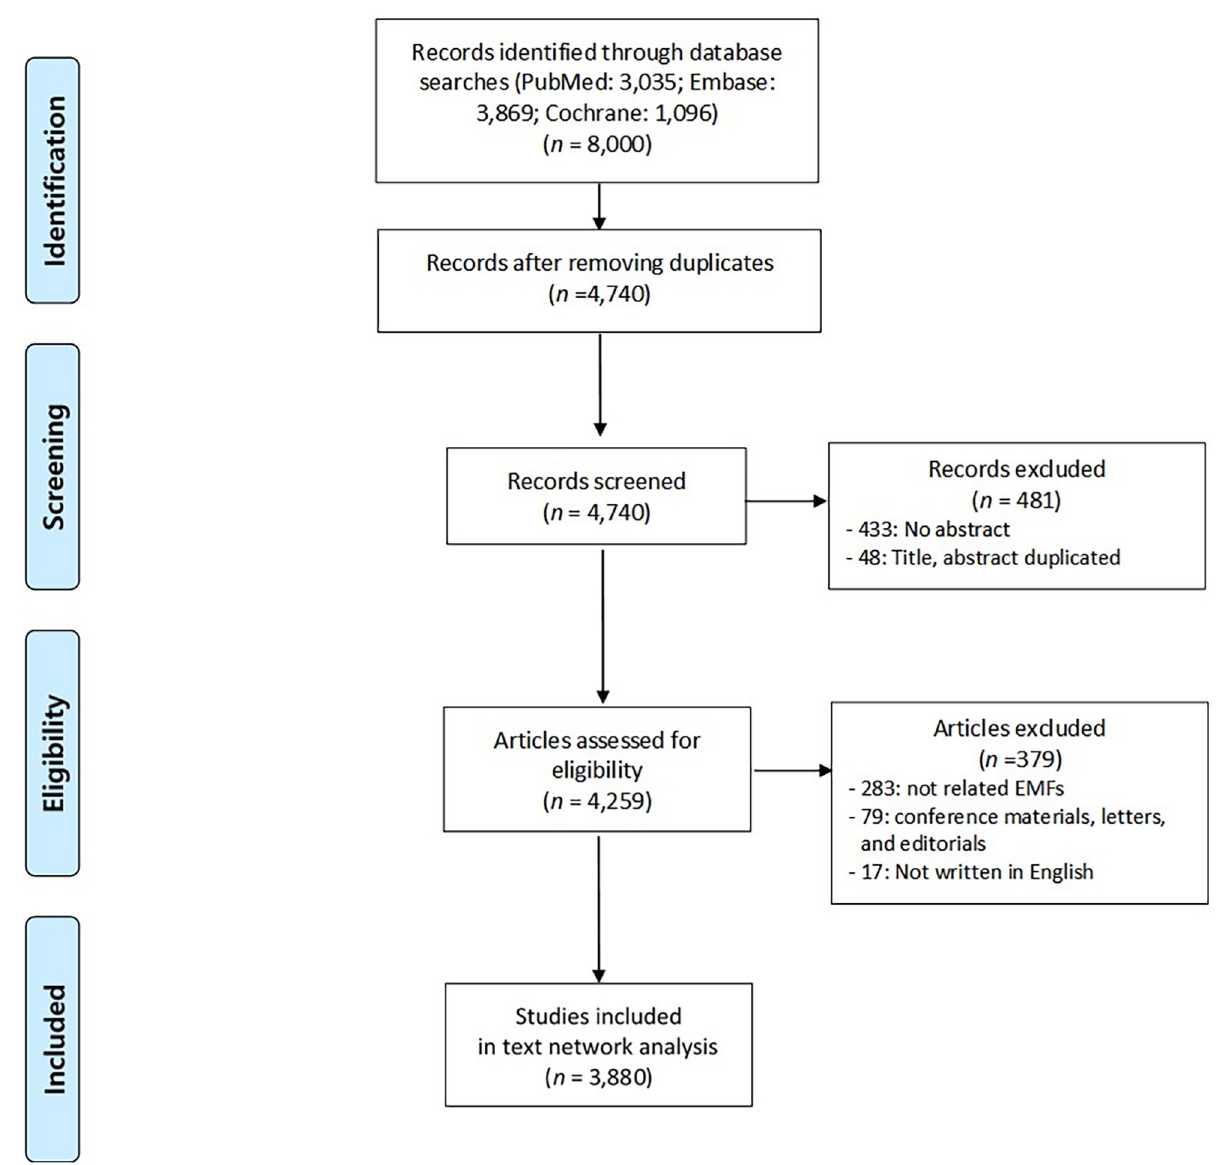
Fig 1. The flowchart of the article inclusion process in health effects of the electromagnetic fields. This shows the process from the search results in 3 databases to the selection of the final included articles.